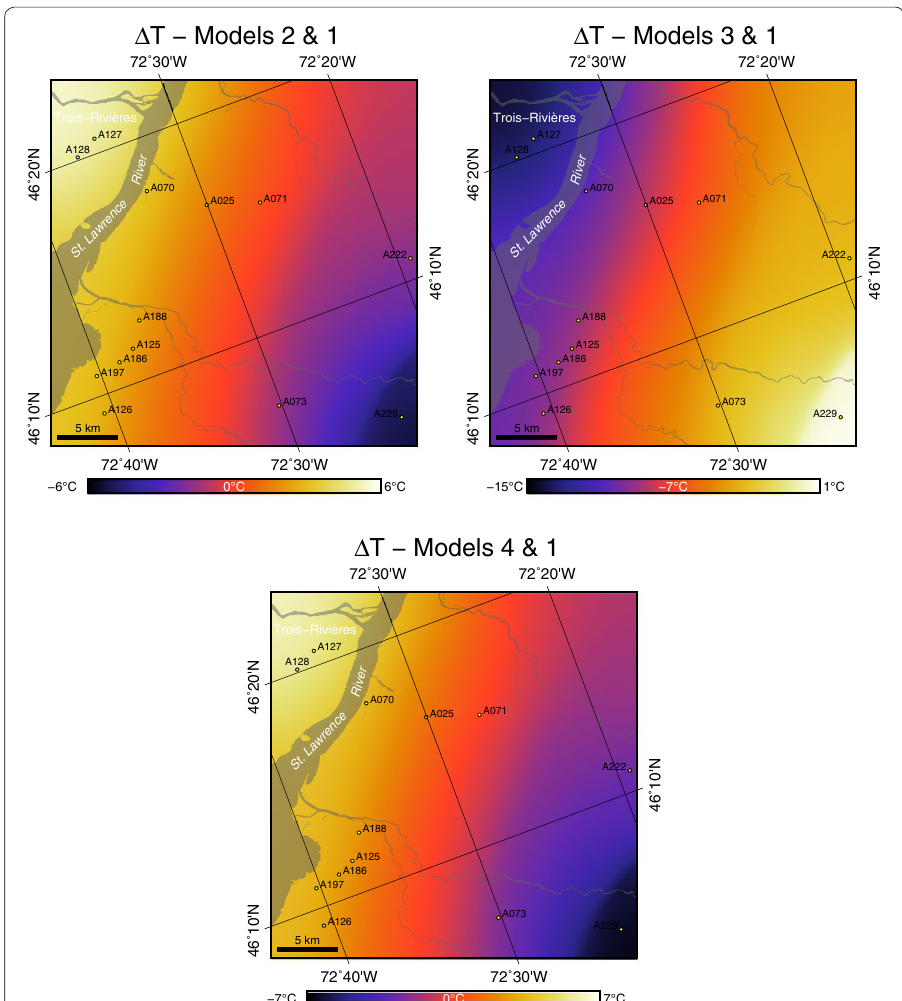
Fig. 8 Temperature difference between Models 2–4 and Model 1 at 5 km